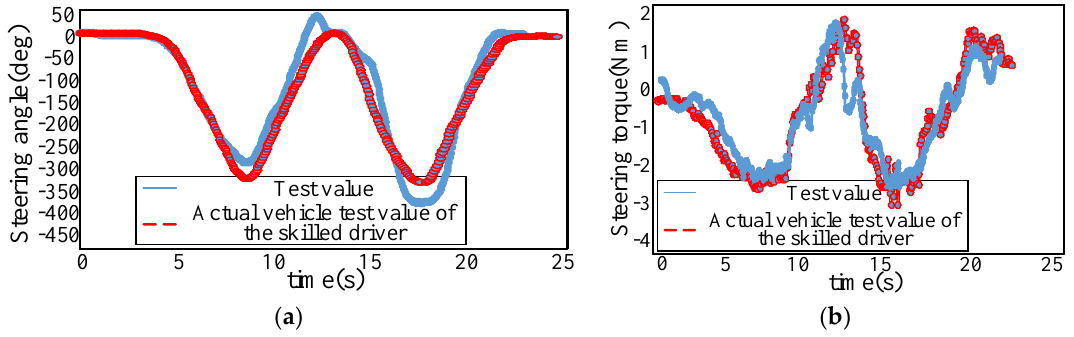
Figure 13. Comparison of test results under normal right-steering condition. ( a ) Comparison of steering wheel angle; ( b ) Comparison of steering wheel torque.